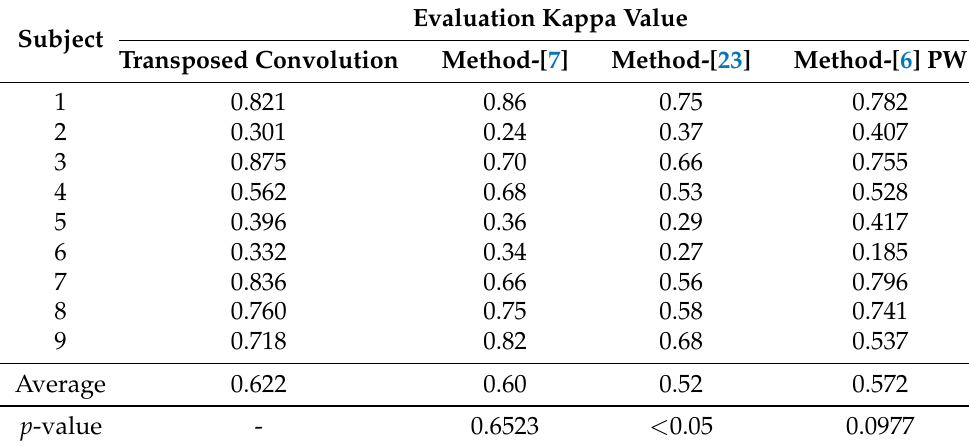
Table 7. Comparisons of the evaluated kappa values with previous